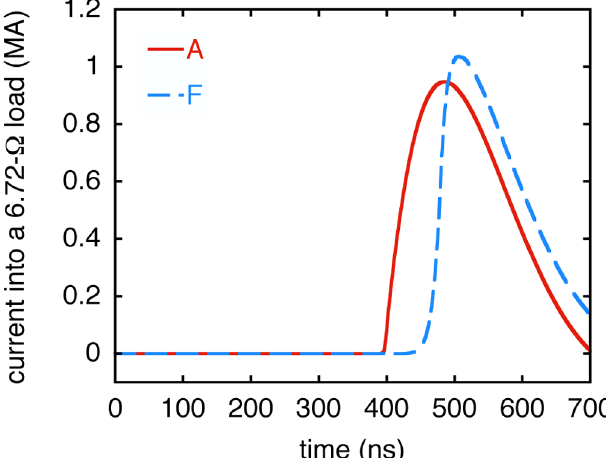
FIG. 7. (Color) Comparison of current-shape Awith one that can be achieved when t j þ 1 (cid:1) t j ¼ (cid:1) c þ 1 : 4 ns , for all values of j between 1 and n (cid:1) 1 , where t j is the time at which the switches of the j th cavity are